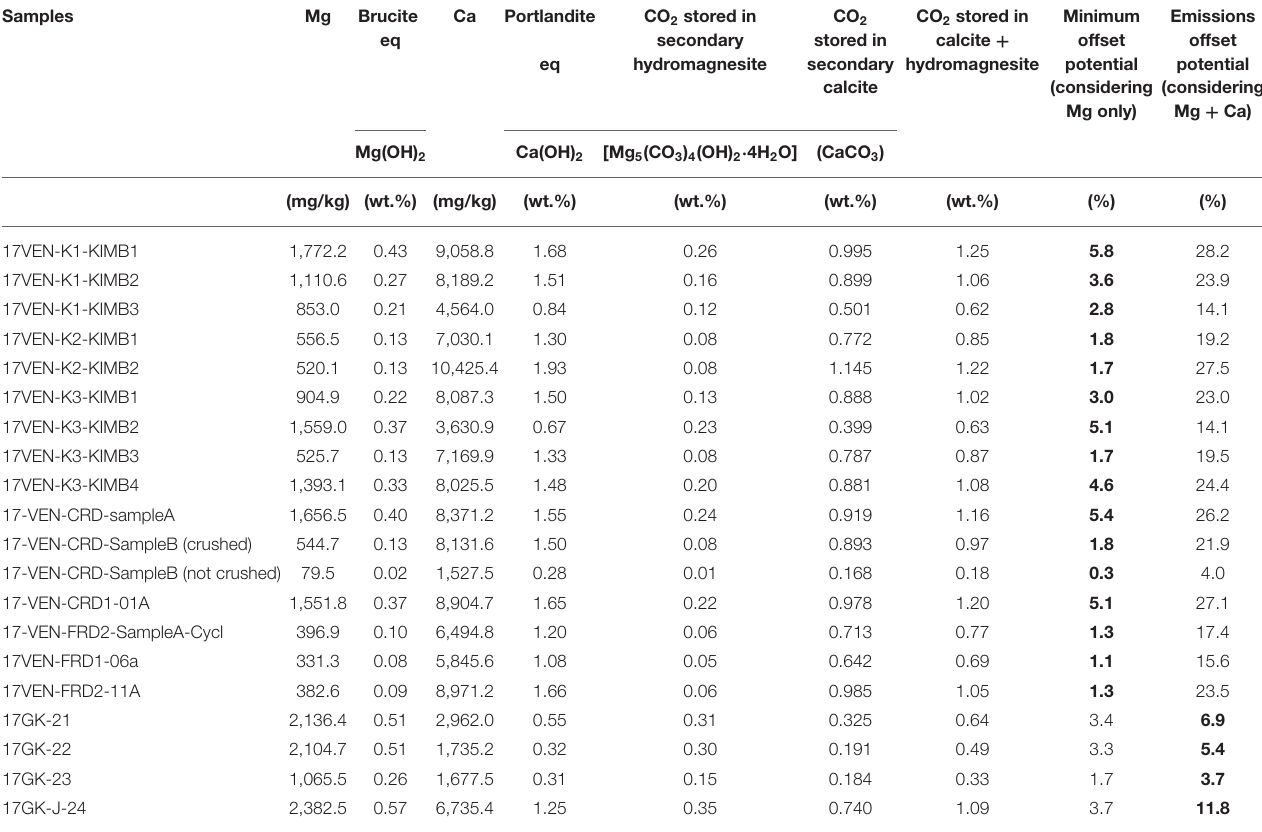
TABLE 3 | Annual emissions offset potentials from cation exchange capacity at Venetia and Gahcho Kué mines.